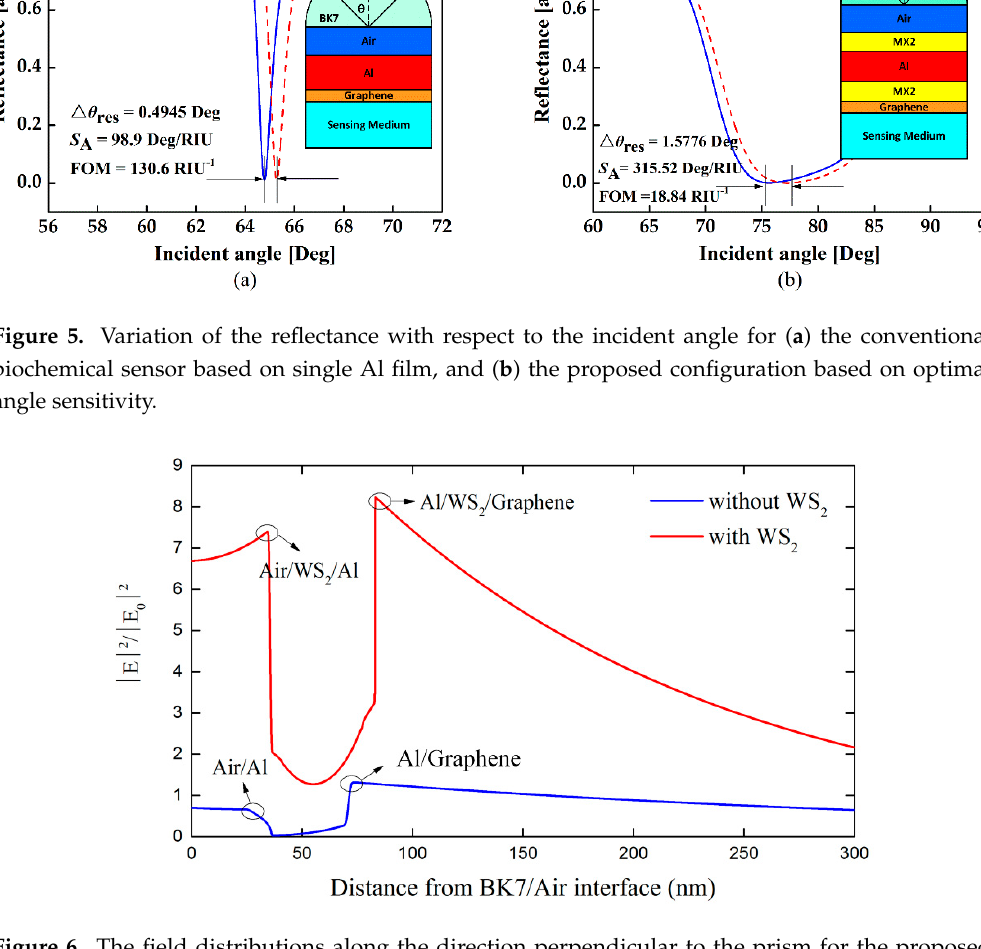
Figure 6. The field distributions along the direction perpendicular to the prism for the proposed configuration with seven WS 2 layers and the conventional configuration without WS 2 layers.